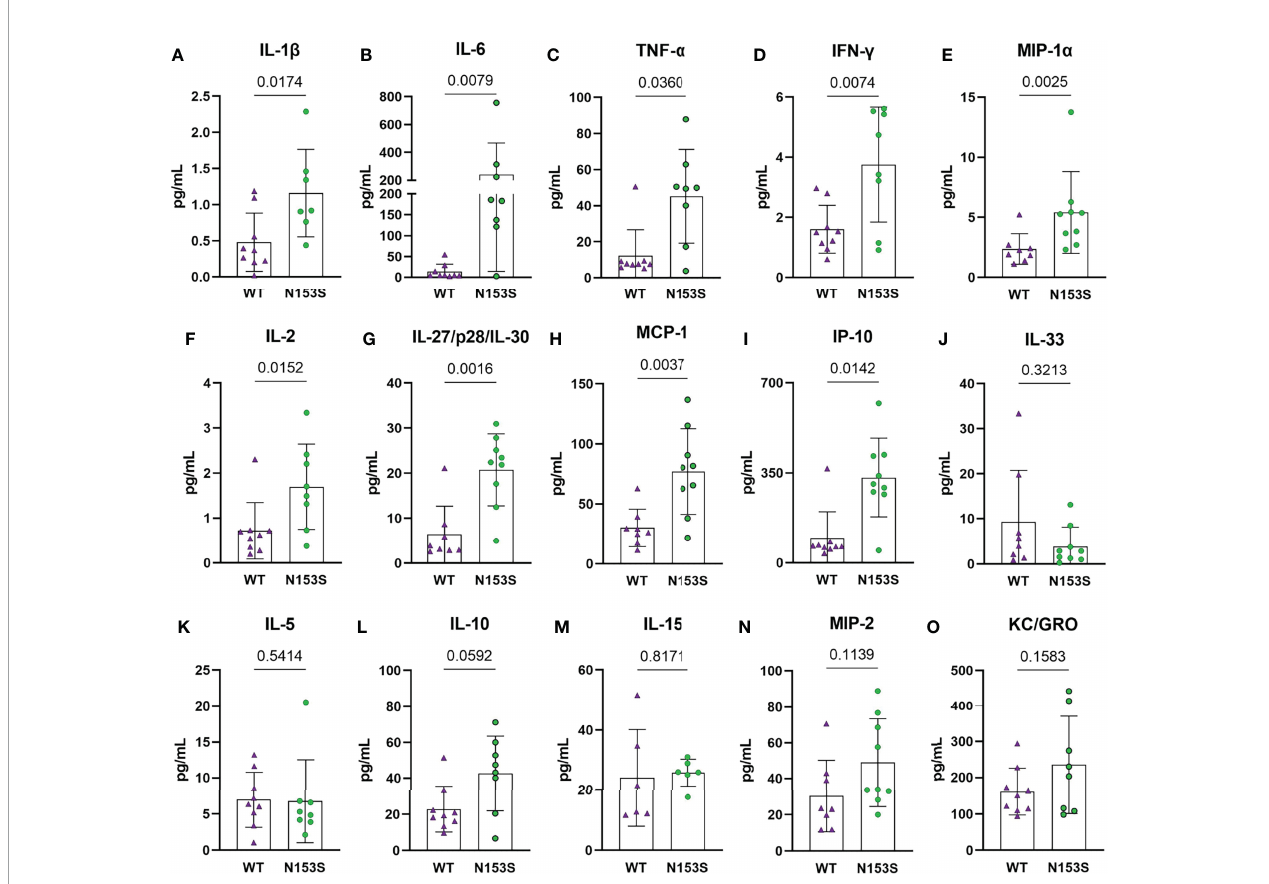
FIGURE 1 | Circulating cytokine levels indicate a proin fl ammatory environment in N153S mice. Multiplex assay analysis shows a signi fi cant increase in the concentrations of (A) IL-1 b , (B) IL-6, (C) TNF- a , (D) IFN- g , (E) MIP-1 a , (F) IL-2, (G) IL-27/p28/IL-30, (H) MCP-1, and (I) IP-10 in the plasma of N153S mice. Levels of (J) IL-33, (K) IL-5, (L) IL-10, (M) IL-15, (N) MIP-2, and (O) KC/GRO did not differ between genotypes. Data are shown as mean ± SD. (n = 9 animals/genotype) Signi fi cance was determined using an unpaired t-test or Mann-Whitney test, as